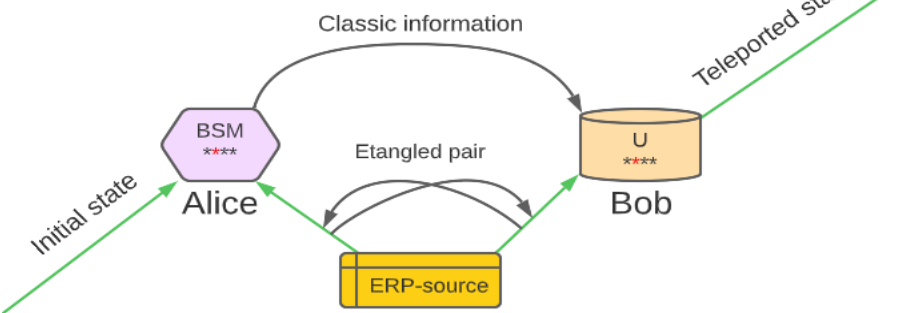
Figure 3. Results of the protocol CSLOE – 2022 work. Table 1. Sifted key.